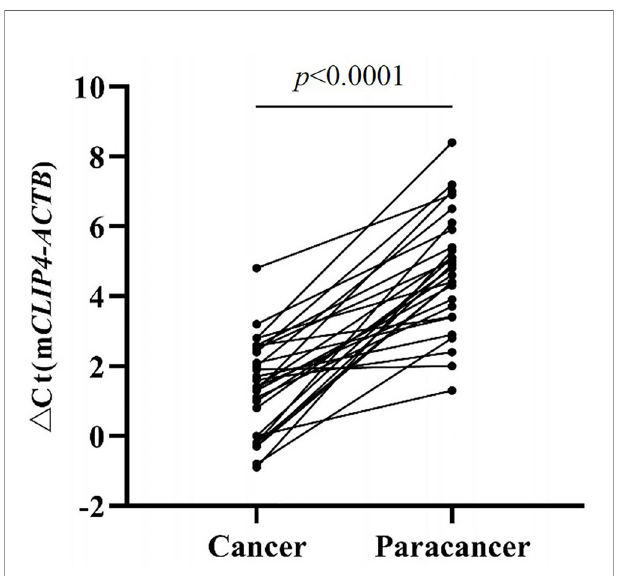
FIGURE 2 | The Methylation levels of CLIP4 gene in CRC tissues and paired adjacent paracancerous tissues.